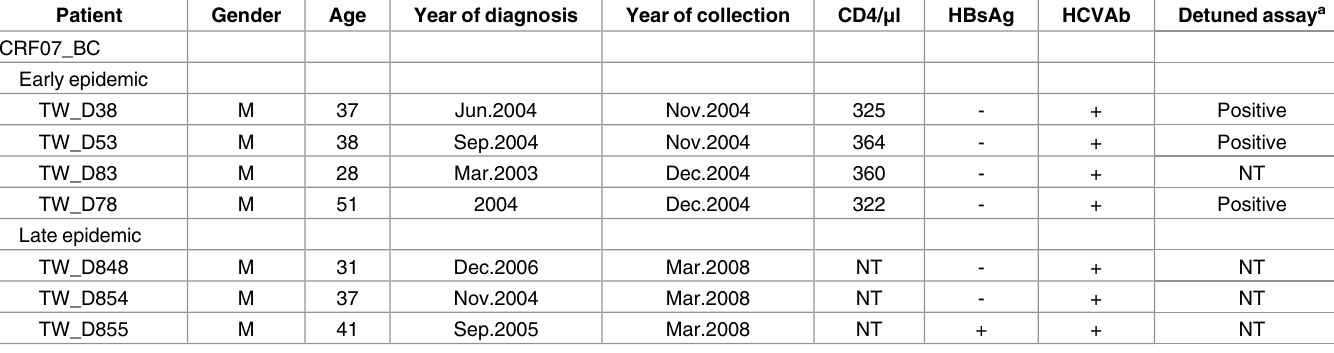
Table 1. Demographic and clinical data of HIV-1 infected